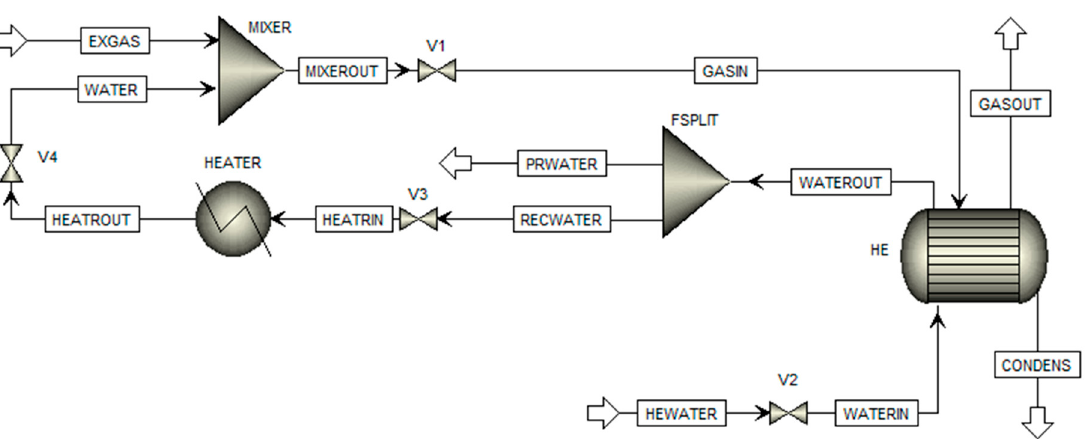
Figure 1. Flowsheet for the humidification of the flue gas using water.